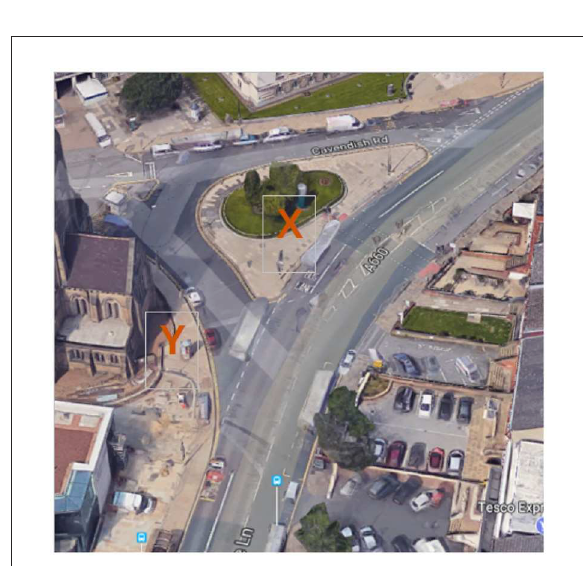
FIGURE9 Intersection for the interactions’ observation near the University of Leeds (Camara et al., 2018b,c).